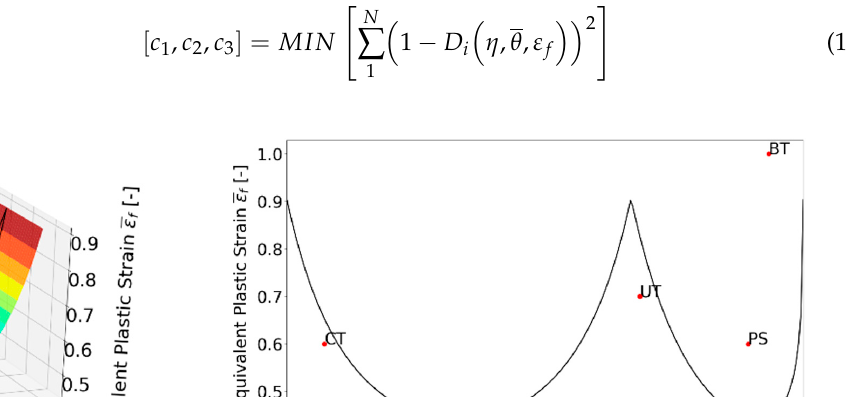
Table 5. Calibrated parameters of Swift and MMC models.